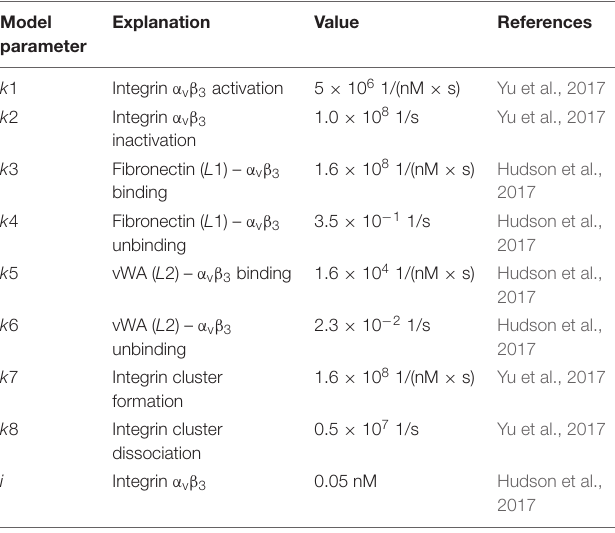
TABLE 1 | Parameters used in the ODE model, their values and